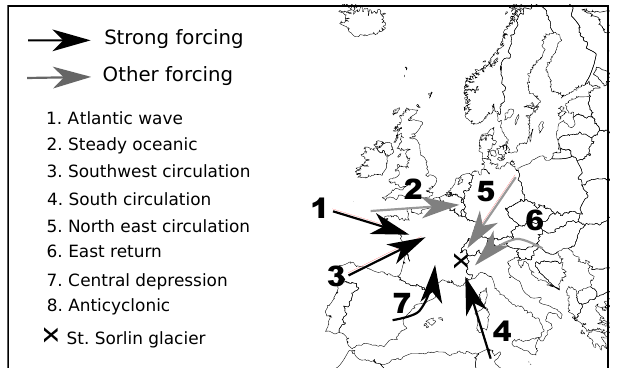
Figure 2. Direction of the atmospheric flow in the lower atmo- spheric layers for different WPs (adapted from Garavaglia et al., 2010). (black arrows) Direction of the flow for the WPs associated with SF and (grey arrows) direction of the flow for the other WPs. No flow direction is shown for WF conditions (WP8) since atmo- spheric wind speed was weak and direction ill-defined for these con-